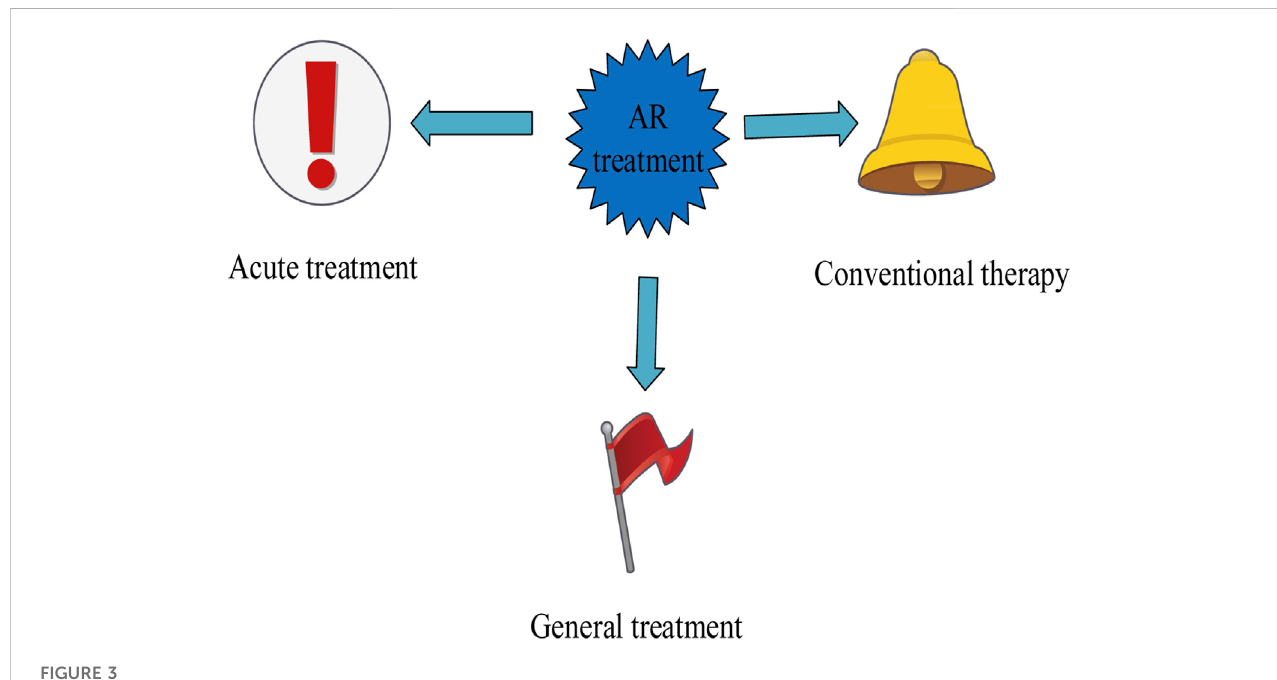
FIGURE 3 Treatment of